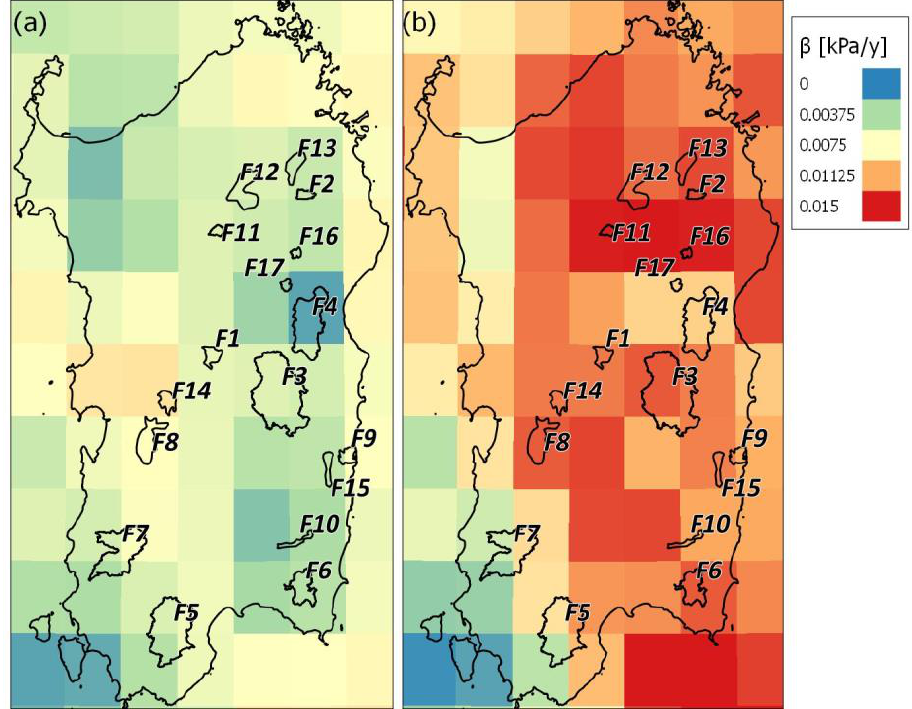
Figure 8. Spatial distribution of the Theil-Sen slope estimator in ( a ) annual VPD ( VPDy ) and ( b ) in ‘extended summer season’ VPD ( VPD es ) derived from ERA5 during the 1990–2020 period. The thin black outlines indicate the 17 forests analyzed.